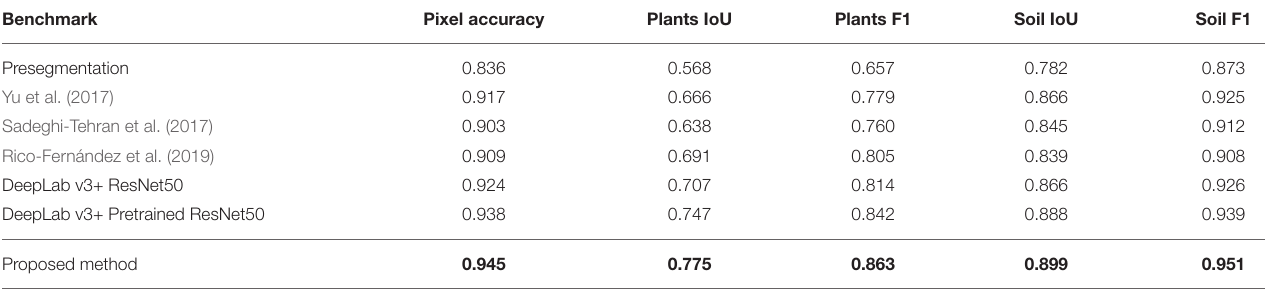
TABLE 2 | Benchmarks on the EWS